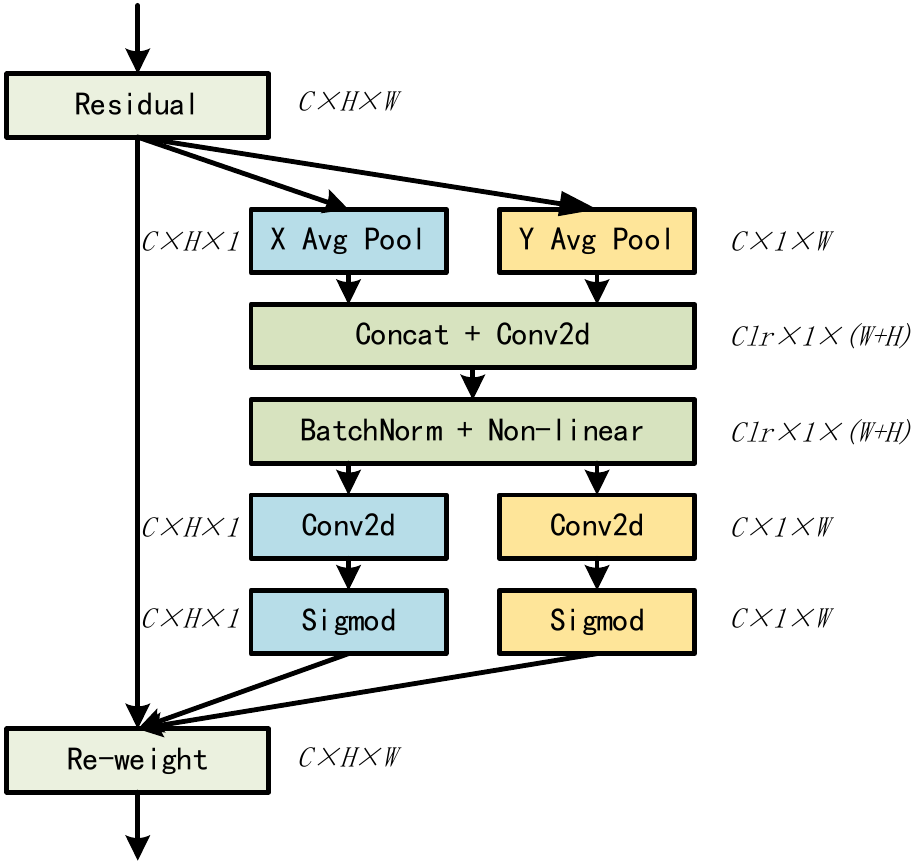
Figure 1. Coordinate Attention working diagram, where AVG pool refers to 1D global pooling, and the notes on both sides are the number of channels and the width and height of the characteristic diagram.